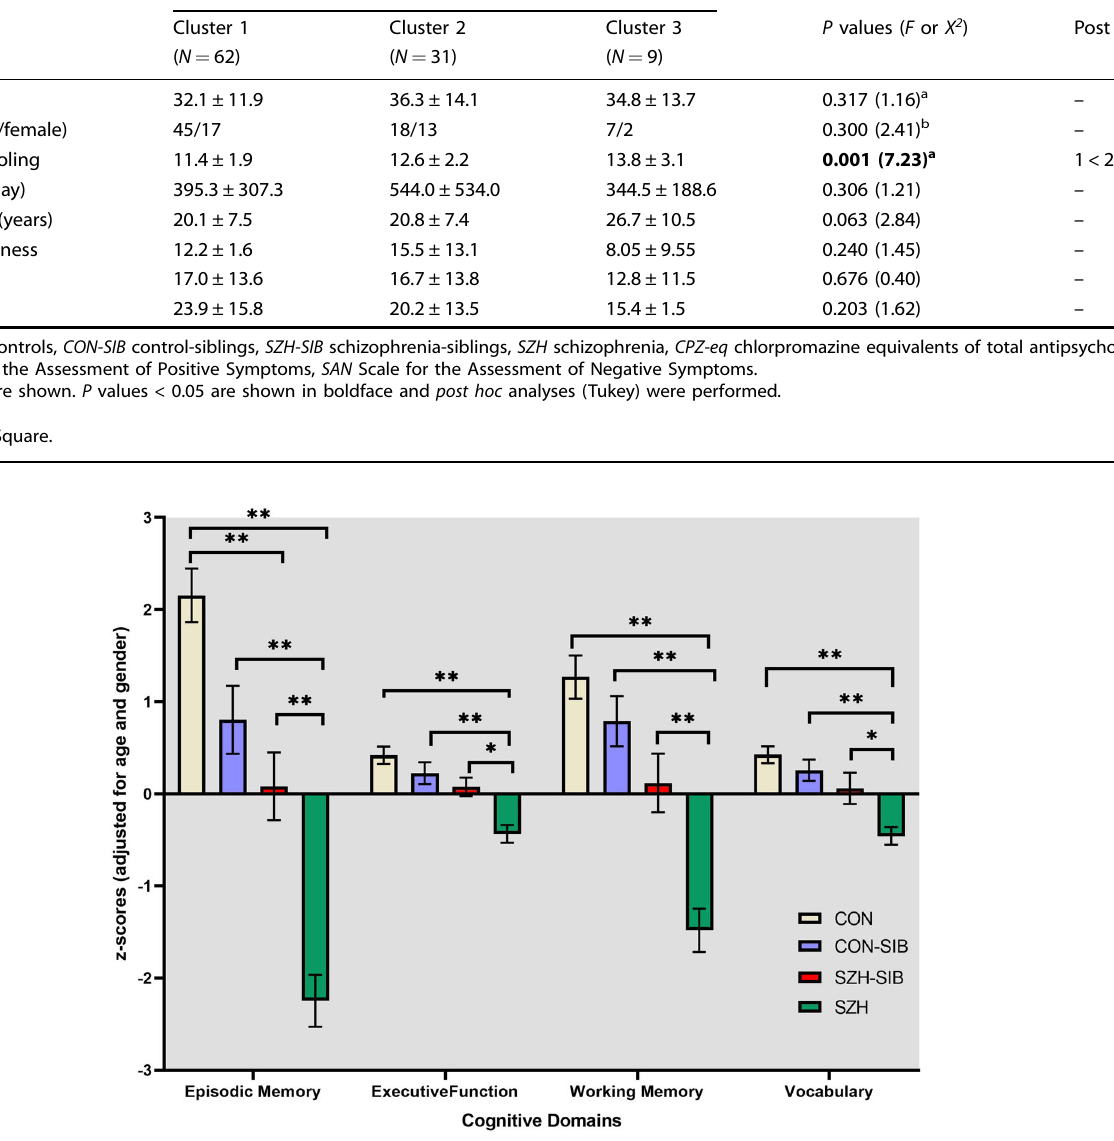
Fig. 2 Cognitive domain score differences between Controls (CON), their siblings (CON-SIB), schizophrenia patients (SZH), and their unaffected siblings (SZH-SIB). ** Post hoc p < 0.01, *Post hoc p <